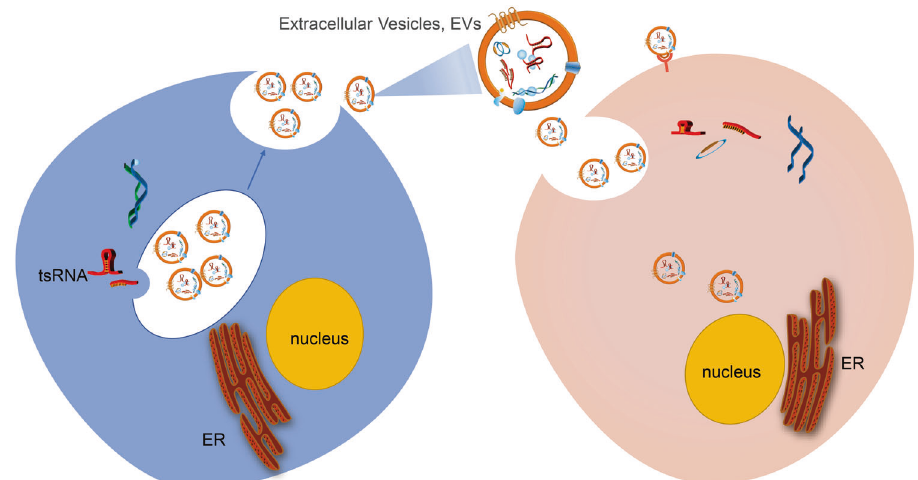
Fig. 7 The function of tsRNA on cell-to-cell communication. tsRNA exists stably in extracellular vesicles and plays an essential role in intercellular